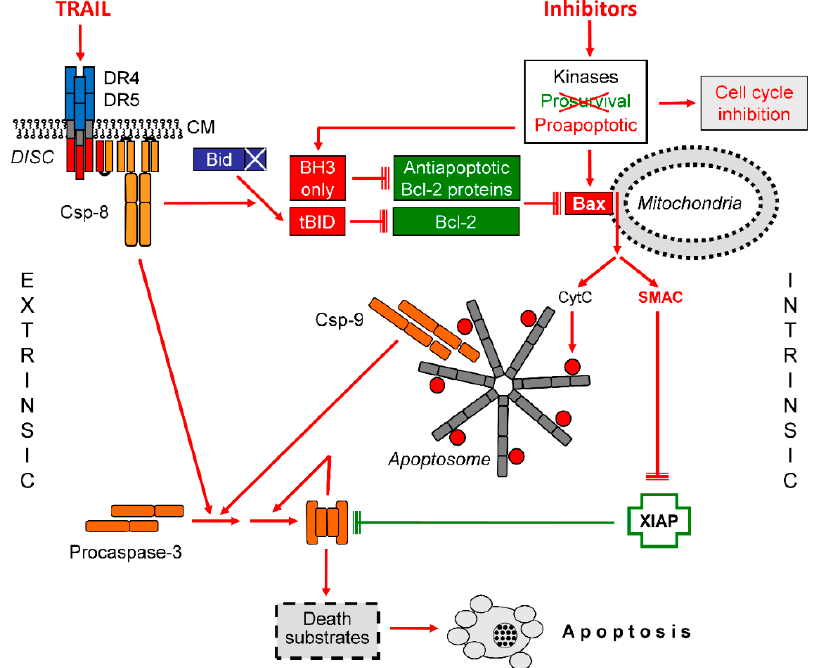
Figure 4. Steps of TNF-related apoptosis-inducing ligand (TRAIL) sensitization in melanoma. The interplay of extrinsic and intrinsic apoptosis pathways for TRAIL signaling in melanoma cells